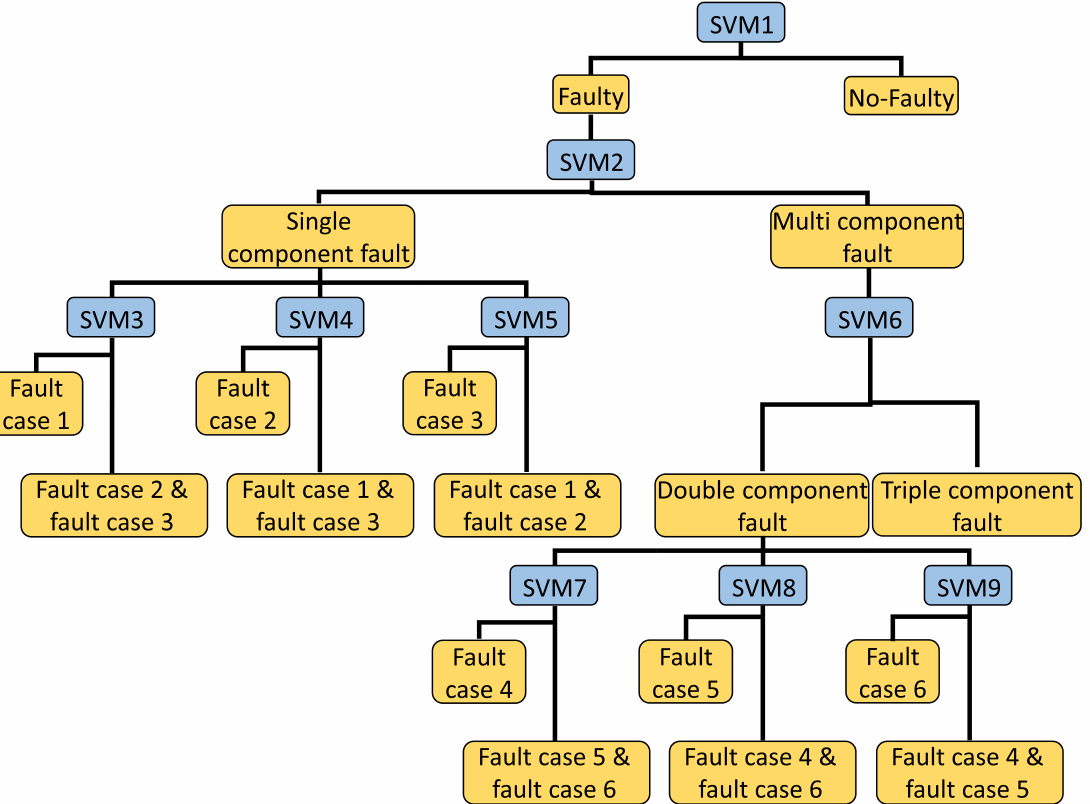
Figure 18. An example of the net of SVMs used for fault classification